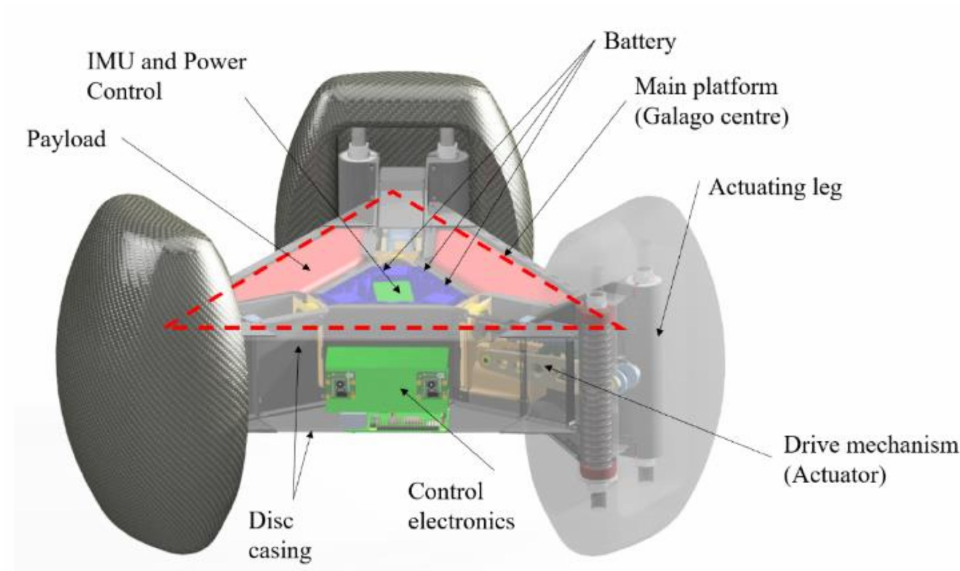
Figure 1. Design visualization of Hopter, top of the cover, and one of the front legs are semi- transparent to show the interior